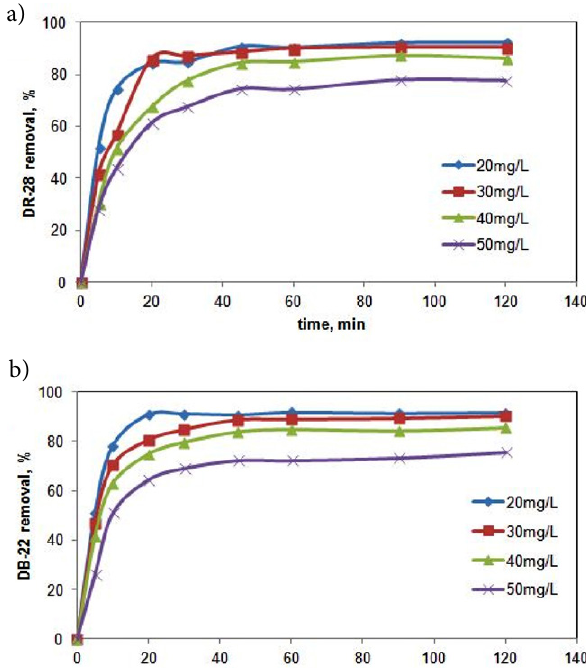
Fig. 9. Effect of initial dye concentration and contact time on the removal of (a) DR-28 and (b) DB-22 (pH: original, temperature: 21 °C (for DR-28), 40 °C (for DB-22), adsorbent: KZF, adsorbent amount: